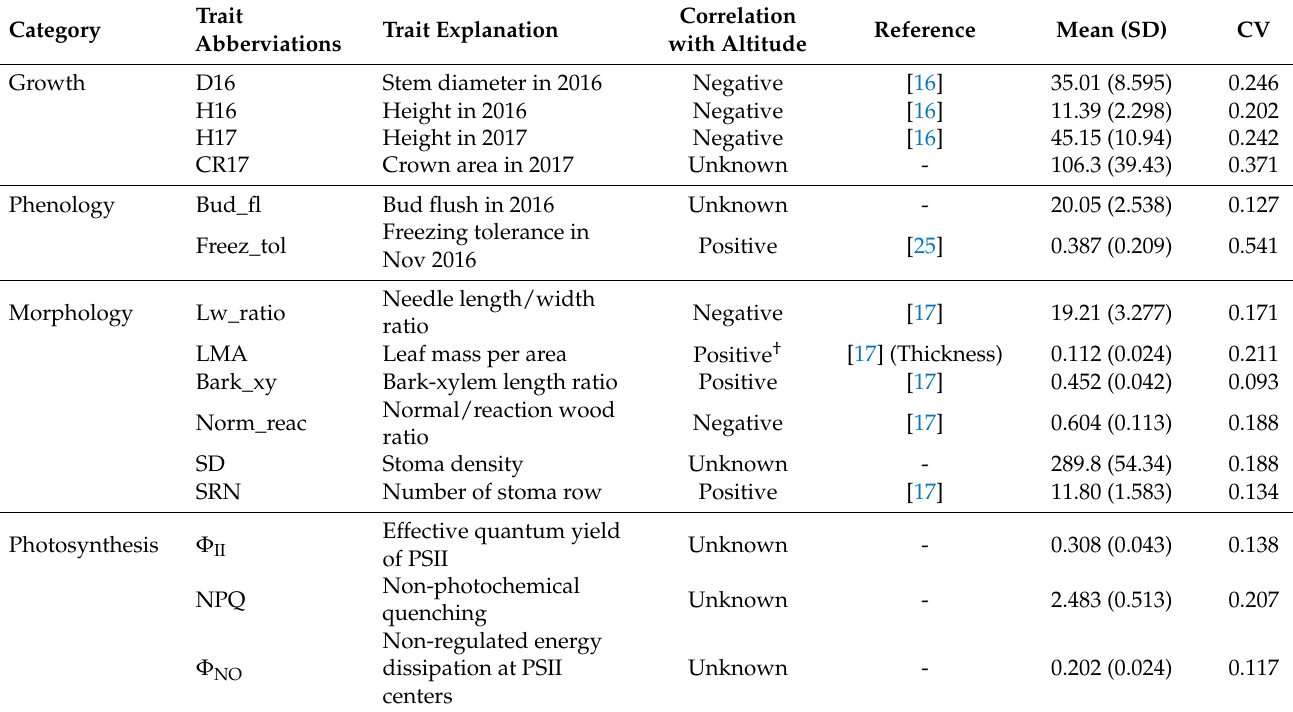
Table 2. The 15 functional traits investigated in this study. The correlation between functional traits and altitude was demonstrated in previous studies of Sakhalin fir. The mean values, standard deviations (SD), and coefficients of variation (CV, %) are presented. † Positive: LMA is generally highly correlated with leaf